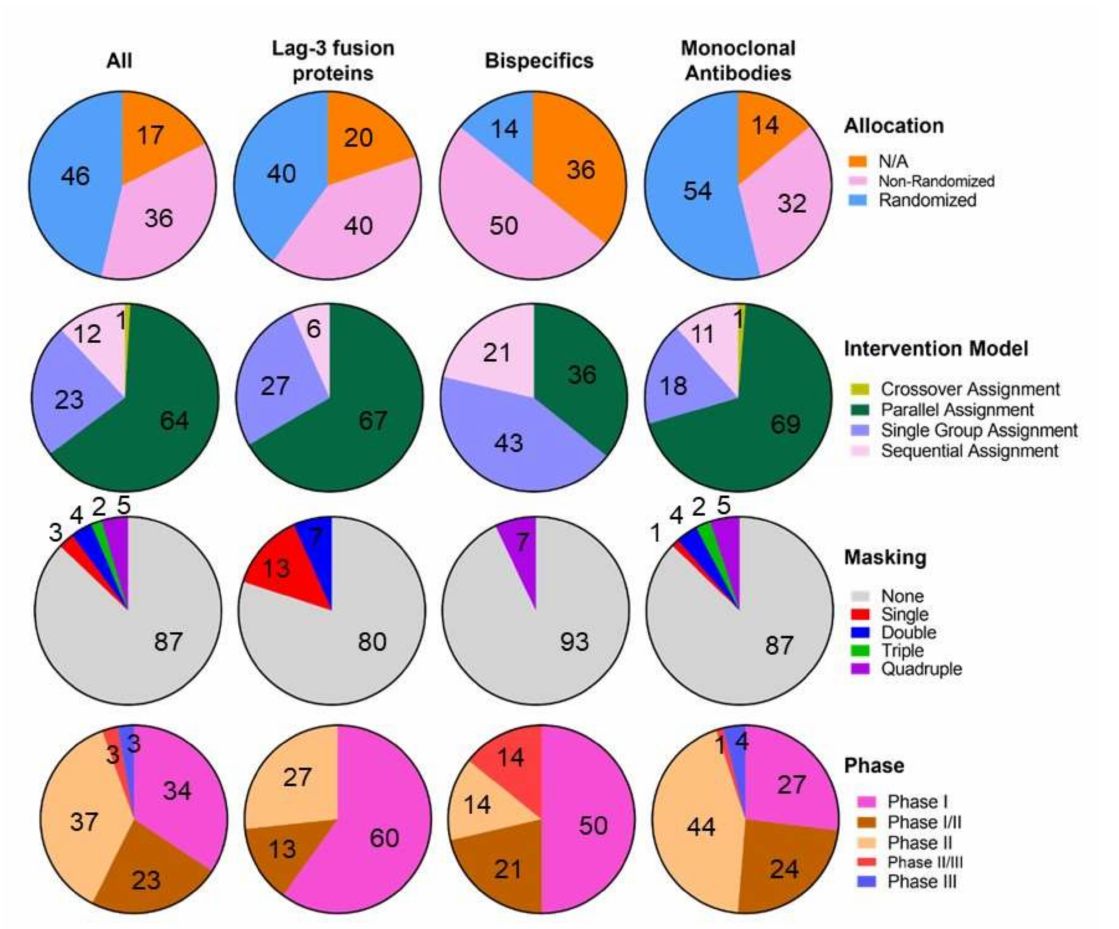
Figure 1. LAG-3-targeted therapy clinical landscape allocation, intervention models and masking of LAG-3 targeted molecules including LAG-3 fusion proteins, bispecific molecules and monoclonal antibodies (https://clinicaltrials.gov/, accessed on 29 June 2022). Percentages are indicated within the graphs.